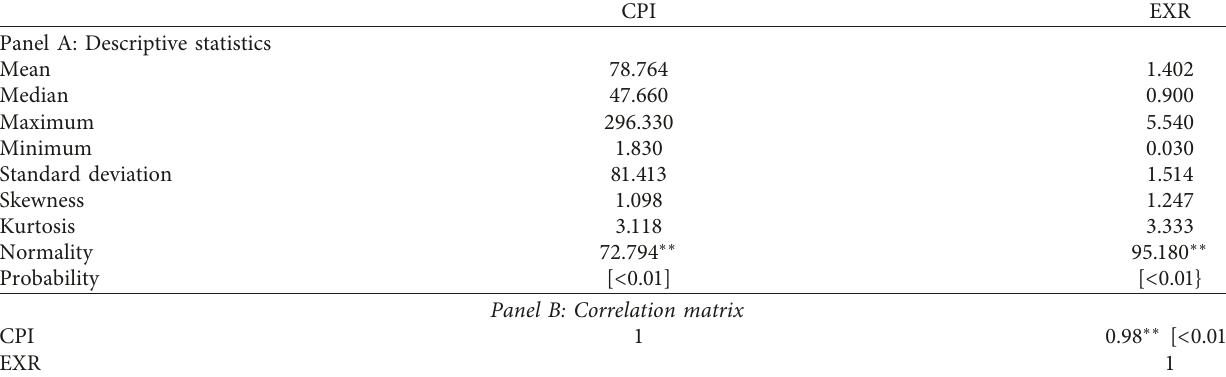
Table 1: Descriptive statistics and correlation